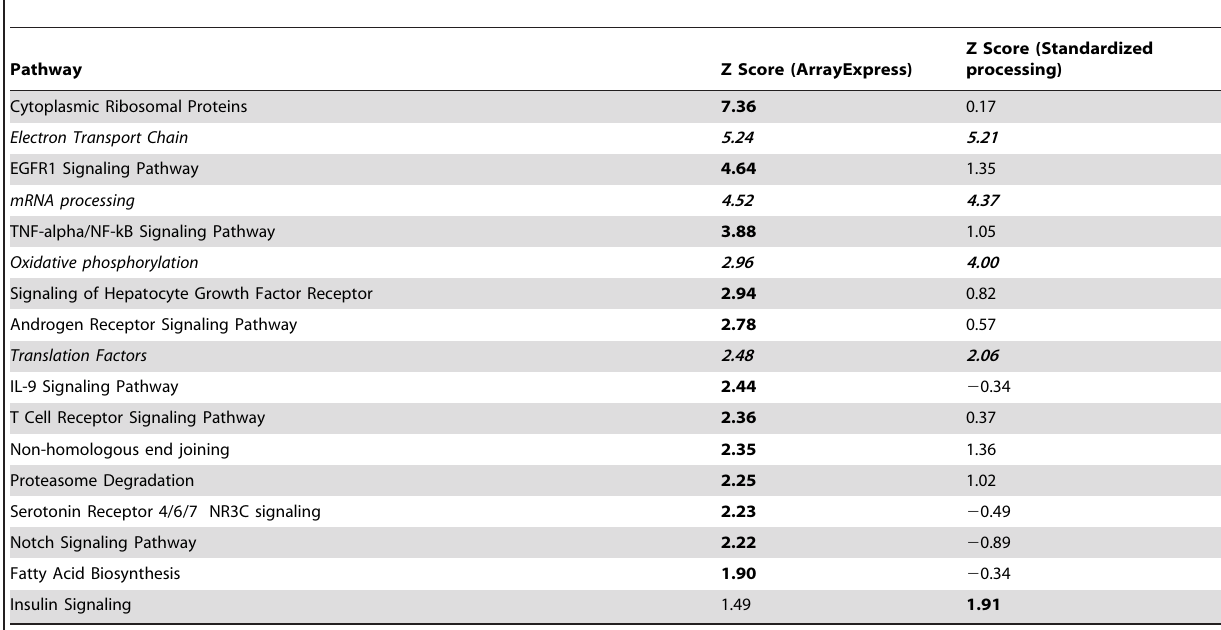
Table 4. PathVisio results of significant pathways found in the dataset by Wallace et al. comparing processed data provided by ArrayExpress with the reprocessed data after quality control.